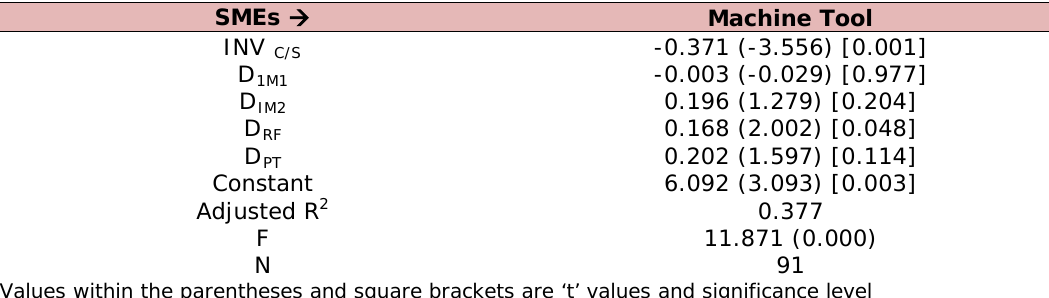
Table 14. “Regression Analysis of ITR with Inventory Cost per Sale, IM, Raw Material Ordering Frequency and Production Type (Dependent Variable: